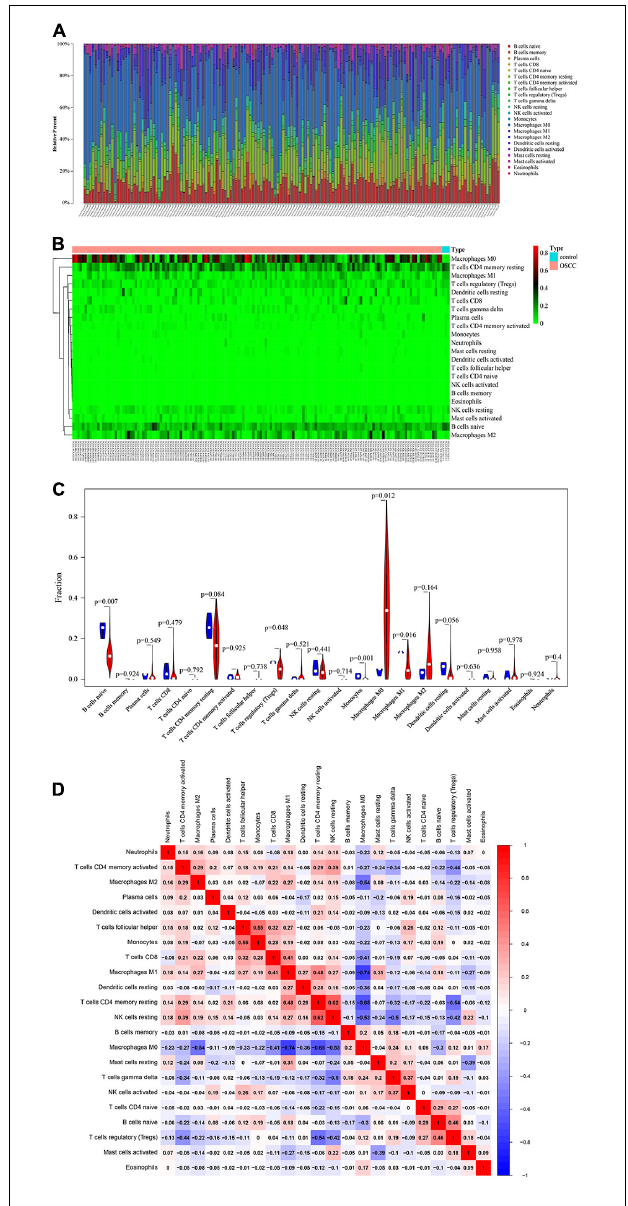
FIGURE 2 | Performance of CIBERORT across TIICs in OSCC. (A) The distribution of 22 tumor-infiltrating immune cells (TIICs) in OSCC samples. The abscissa represents the name of 151 samples, and the ordinate represents the composition ratio of the cells in each sample. Different color represents different types of cells. The longer column of each cell in a certain sample indicates that the proportion of this type of cell is higher in this sample. (B) Heat map of the 22 TIICs proportions in 148 OSCC and 3 healthy control samples. Each column represents a sample, and each row represents one type of immune cell population. The levels of the immune cell populations are shown in different colors, which transition from green to red with increasing proportions. The abscissa represents the 151 samples: The pink represents the 148 OSCC samples, and the sky blue represents the 3 healthy samples. The ordinate represents the expression levels of TIICs in each sample. In the color bar, green represents the low expression of TIICs in samples, red represents the high expression of TIICs in samples, and black represents that the TIICs were not expressed in the samples, meaning the expression level